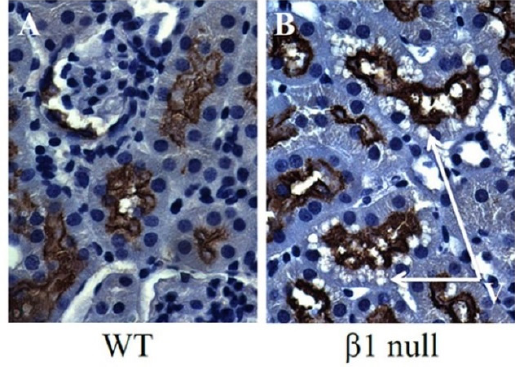
Figure 2. Immunohistochemistry from AMPK knockout mice deficient for the AMPK- β 1 subunit ( β 1 null). Tubular vacuolation, it is noted, co-localises with staining for the proximal tubular marker megalin. V =